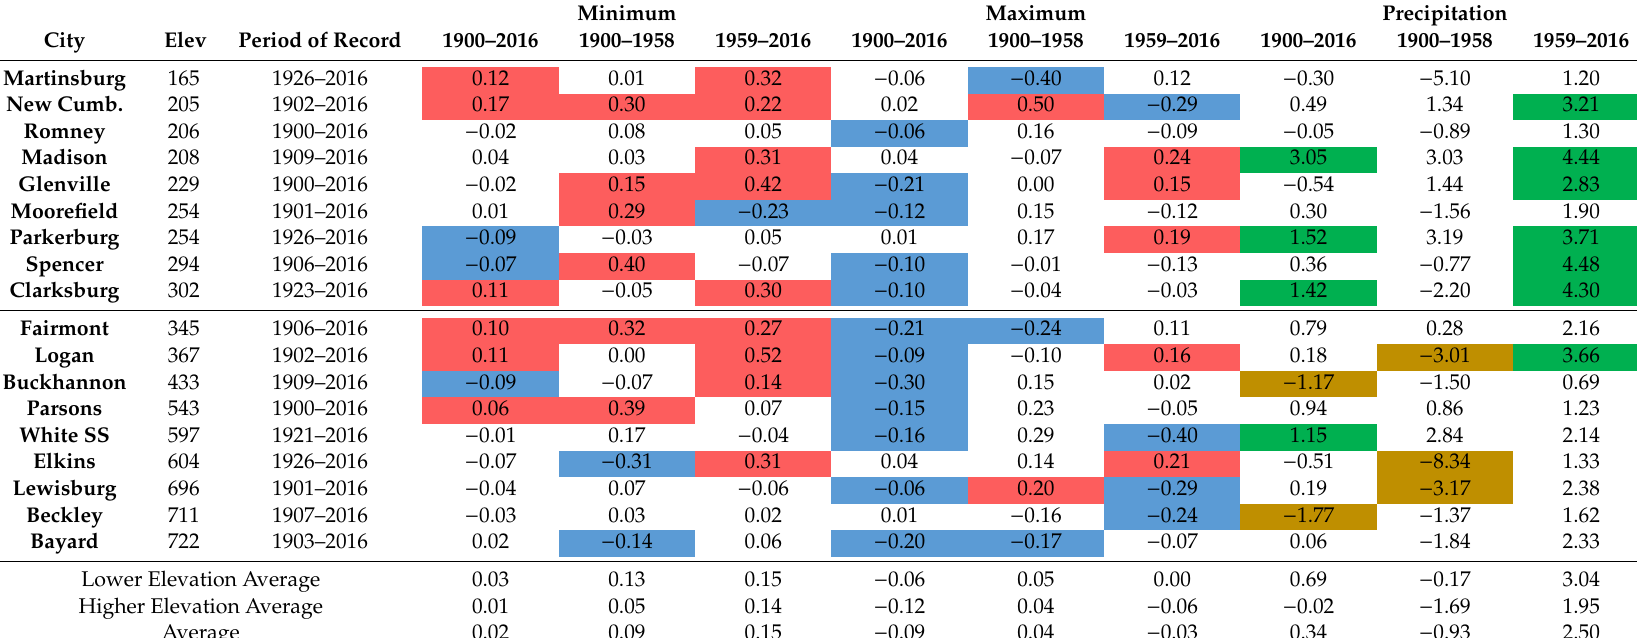
Table 2. Eighteen observation stations in West Virginia, USA. Elevation (m), period of record (POR), and estimated linear slope for minimum temperature ( ◦ C / decade), maximum temperature ( ◦ C / decade), and total annual precipitation (cm / decade). Higher and lower elevation averages refer to above or below the median elevation (323 m),